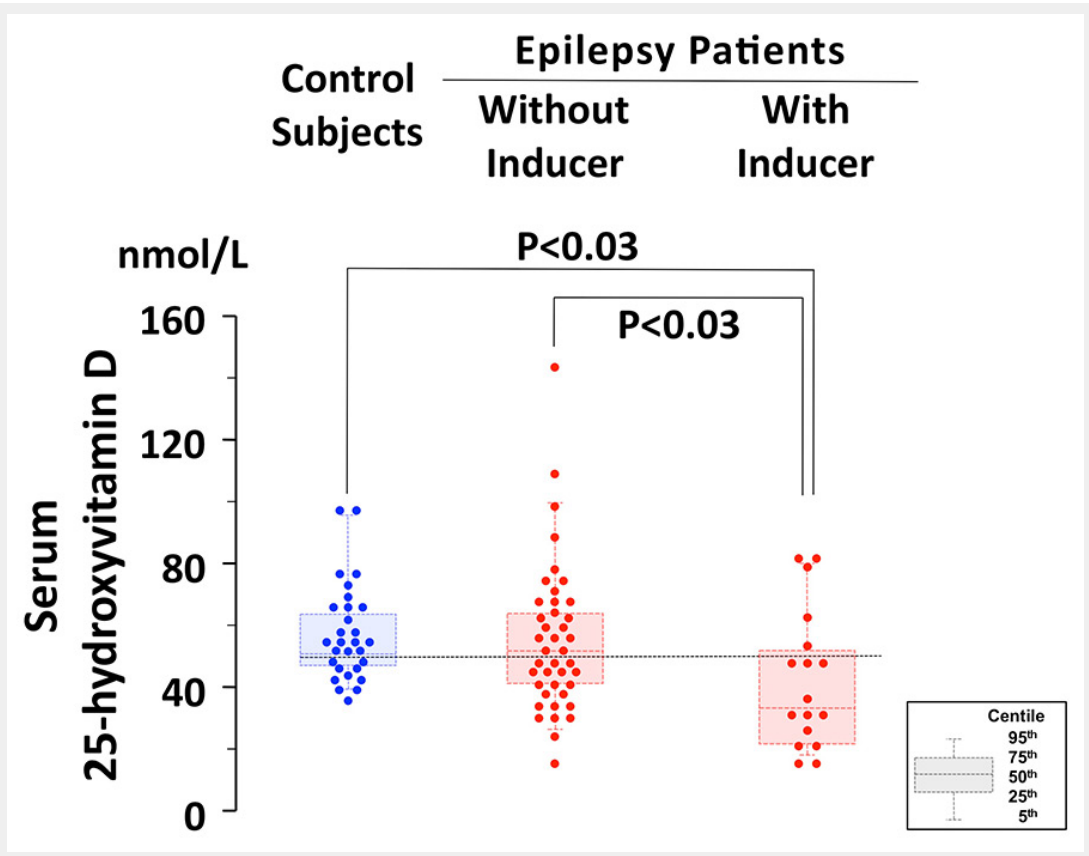
Figure 1 25-hydroxyvitamin D concentration in 29 controls, in 41 epilepsy patients without drugs that induce the metabolism of vitamin D and in 17 patients treated with at least one drug that induces vitamin D metabolism (carbamazepine, oxcarbazepine, phenobarbital or phenytoin). The results are given both as individual values as well as "box and whiskers plot" (the bottom and top of the box are the 25th and 75th centile, the middle of the box is the 50thcentile, i.e., the median, the ends of the whiskers represent the 5th and the 95th centile). The horizontal dotted line denotes the adequacy threshold level of 50